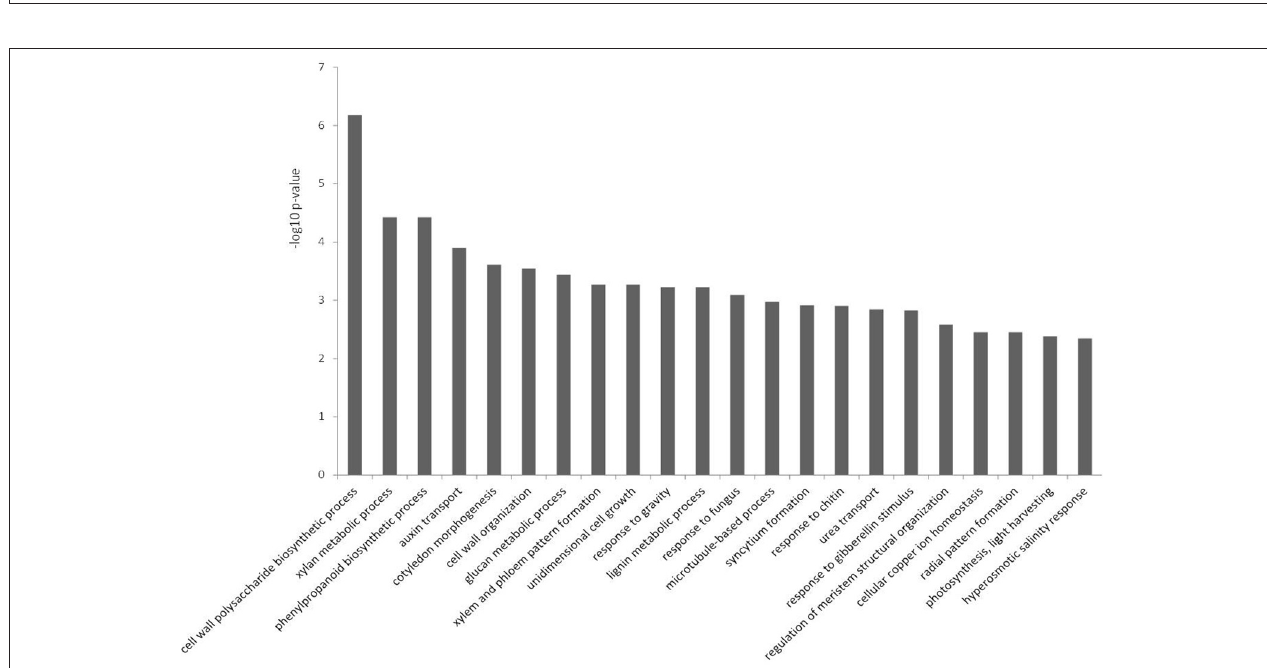
FIGURE 5 | Over-represented Gene Ontologies in the category biological process for the genes down-regulated in response to Phytophthora cinnamomi challenge in Eucalyptus nitens at 5 dpi.